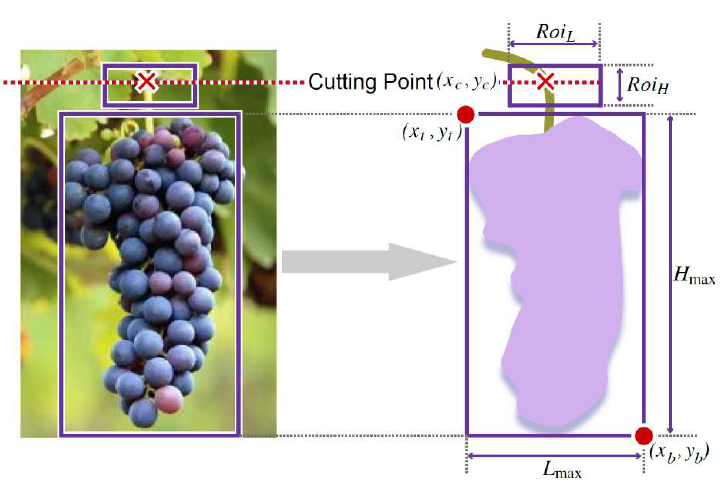
Figure 7. A schematic diagram of the cutting-point-detection approach.